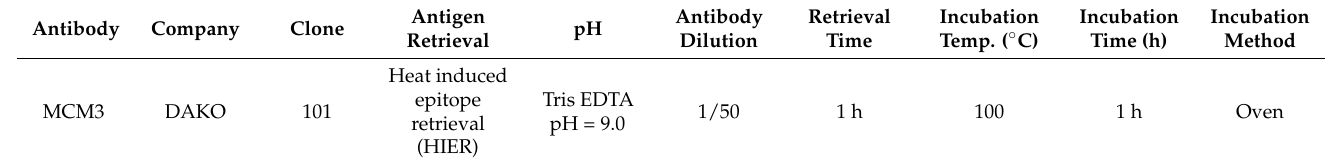
Table 1. Final immunohistochemistry parameters set on archival tissue sections for MCM. Antibody